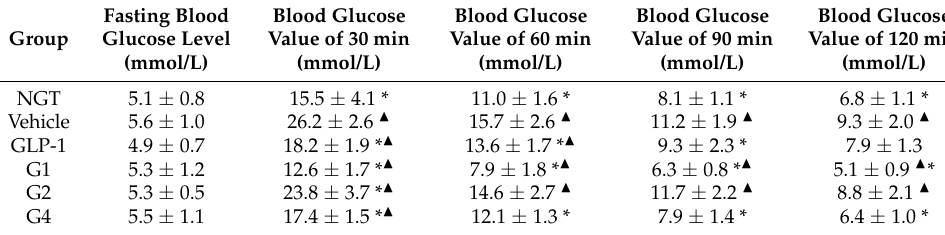
Table A3. The first day’s glucose tolerance test results (M ± SD, n = 8).